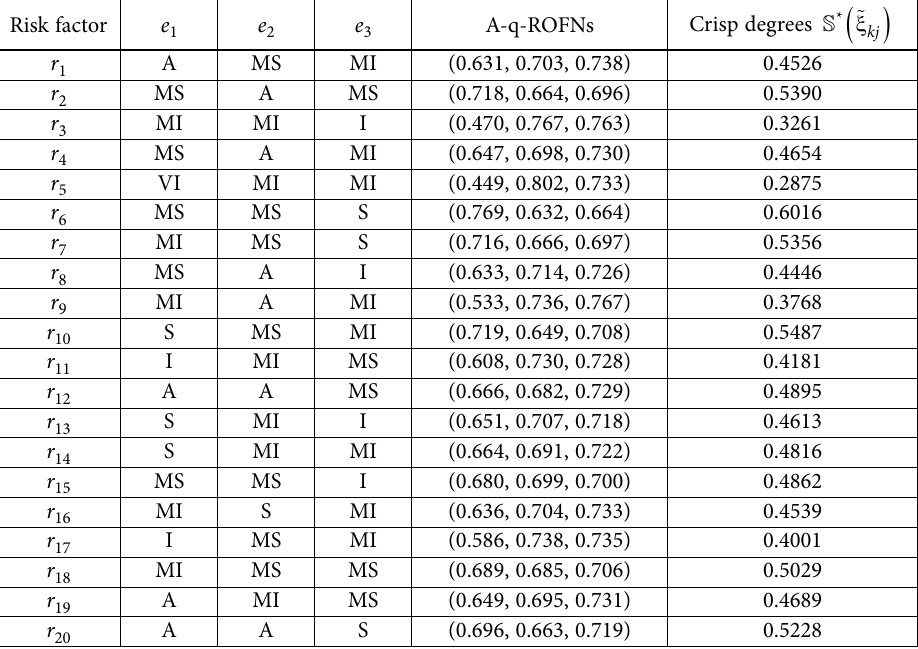
Table 5. Weights of the IoT risks for supply chain management